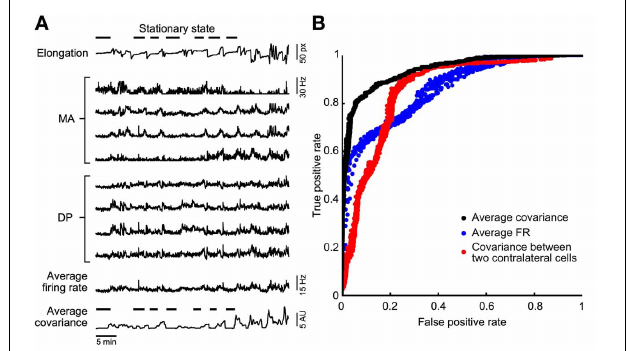
FIGURE 2 | Stationary states classification. (A) A representative experiment in which the leech elongation was measured (top trace, with a discontinued line emphasizing the lack of motion during identified stationary states) and compared to the firing rate recorded from four DP and four MA nerves located in the 11th and 12th segmental ganglia (mid traces). Almost bottom: reproduction of the the Average Firing Rate ( < AFR i > ) obtained from the eight firing rates averaged. Bottom trace: Average Covariance ( < ρ ij > ) obtained from the average of all entries of correlations between firing rates. (B) Comparison of the different classifiers using a ROC analysis. A variation of the